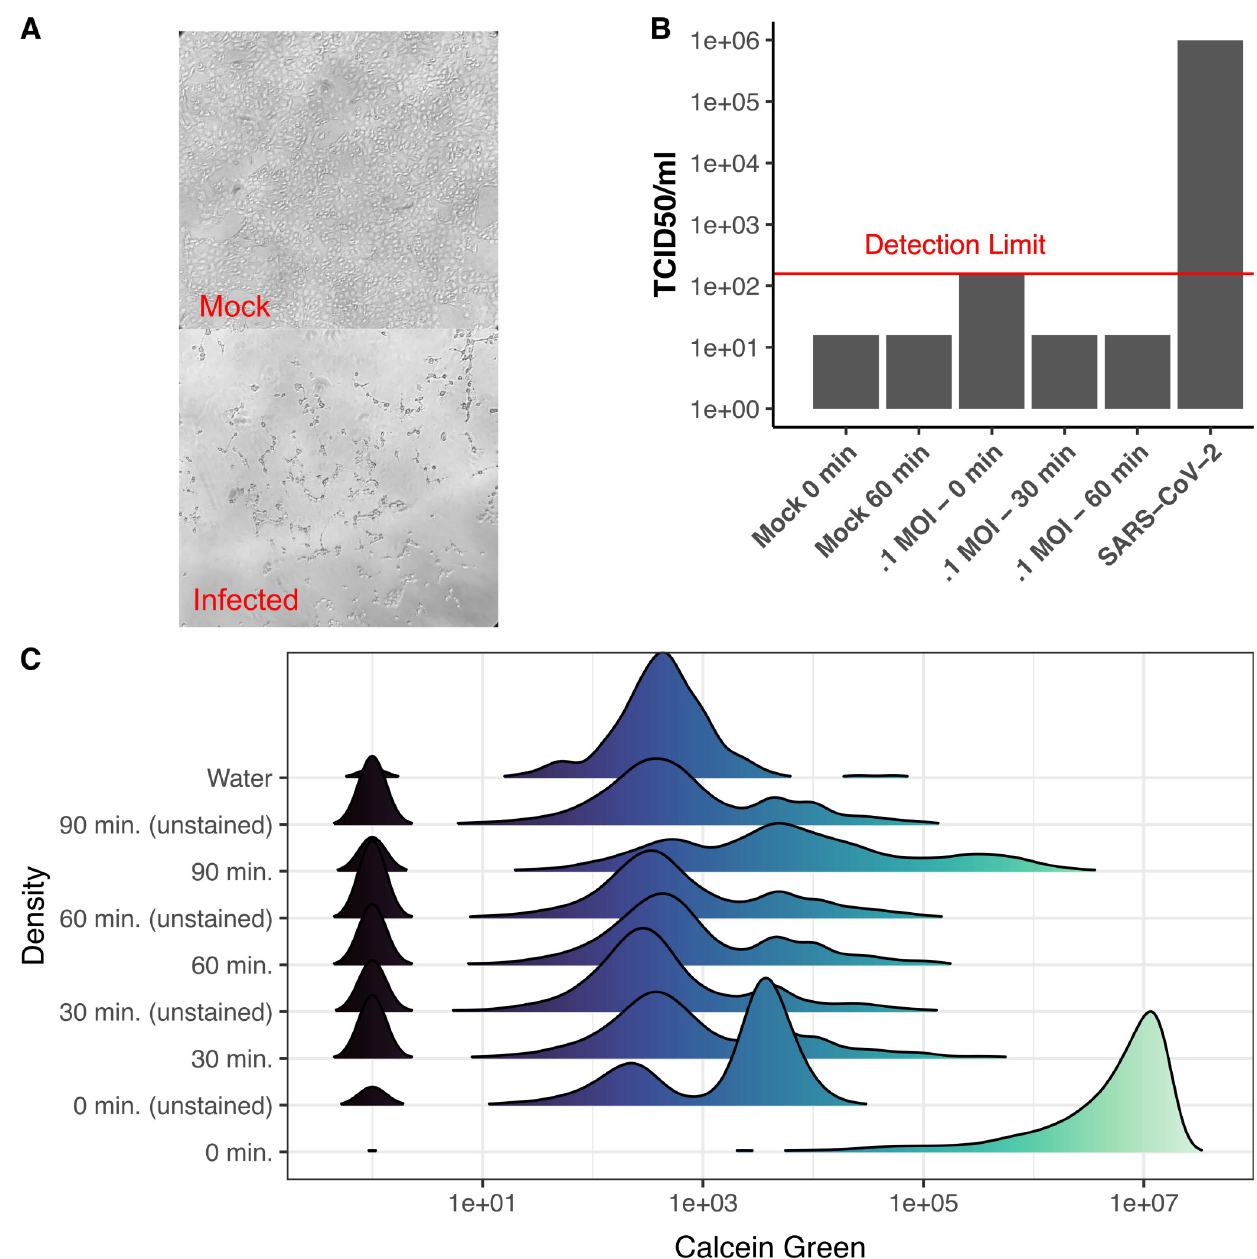
Fig 1. SARS-CoV-2 inactivation and cellular fixation. VeroE6 cells were infected with SARS-CoV-2 for 96 hrs and fixed with methanol-acetone. They were then examined for the presence of SARS-CoV-2-induced cytopathic effects. (A), infectious virus (B) and cell viability (C). (A) Representative images of cytopathic effects of SARS-CoV-2 at 96 hrs post infection at 10X magnification. (B) Bar plot of TCID 50 results. Time indicates the length of methanol- acetone fixation. (C) Density plot showing the kernel density estimation of flow cytometry results from uninfected cells using the cell viability dye, calcein green. M-A indicates methanol-acetone fixation. � indicates unstained control.